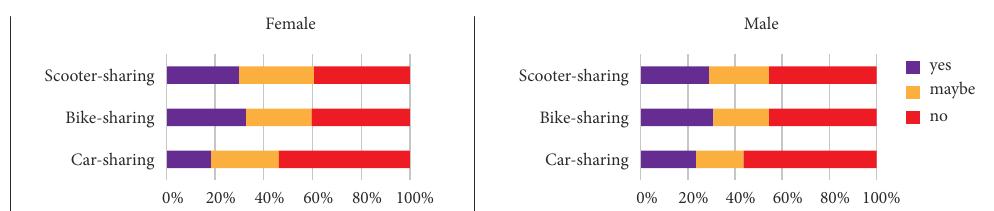
Figure 6. Distribution of residents answers whether they would use the vehicle sharing system if it appeared next month and by the type of transport mode and by